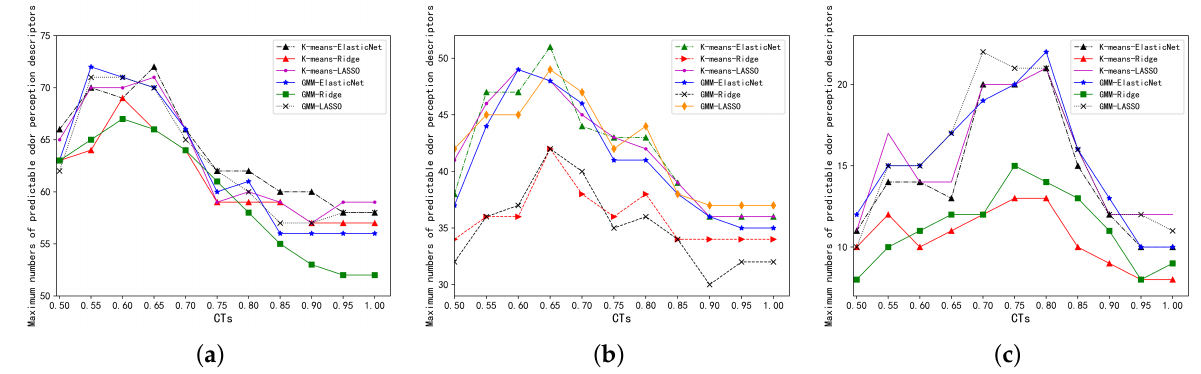
Figure 9. The maximum numbers of the predictable odor perception descriptors of the six combinational models under different predicting metric thresholds. ( a ) The maximum numbers of the predictable odor perception descriptors under the predicting metric threshold of 0.7. ( b ) The maximum numbers of the predictable odor perception descriptors under the predicting metric threshold of 0.8. ( c ) The maximum numbers of the predictable odor perception descriptors under the predicting metric threshold of 0.9.